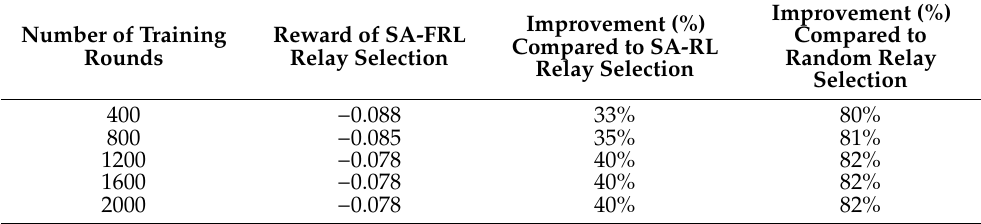
Table 3. Reward of SA-FRL with different amount of pre-training data, simulated channel.